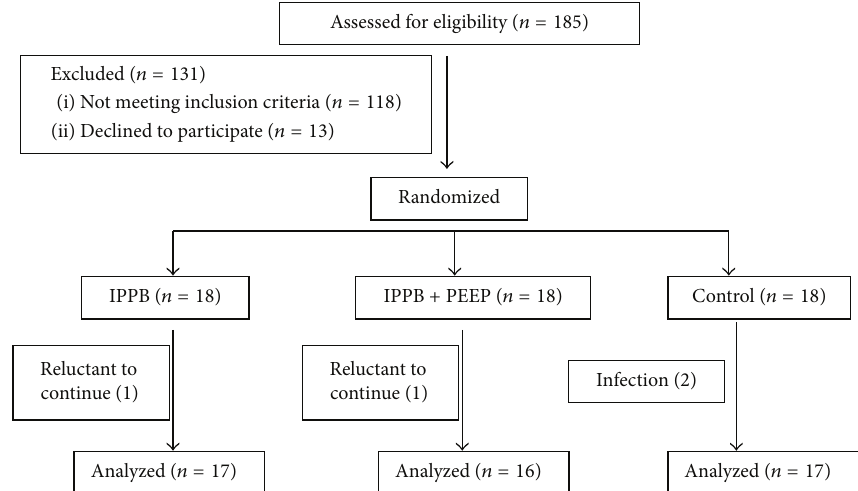
Figure 1: Flow chart of subjects participation and